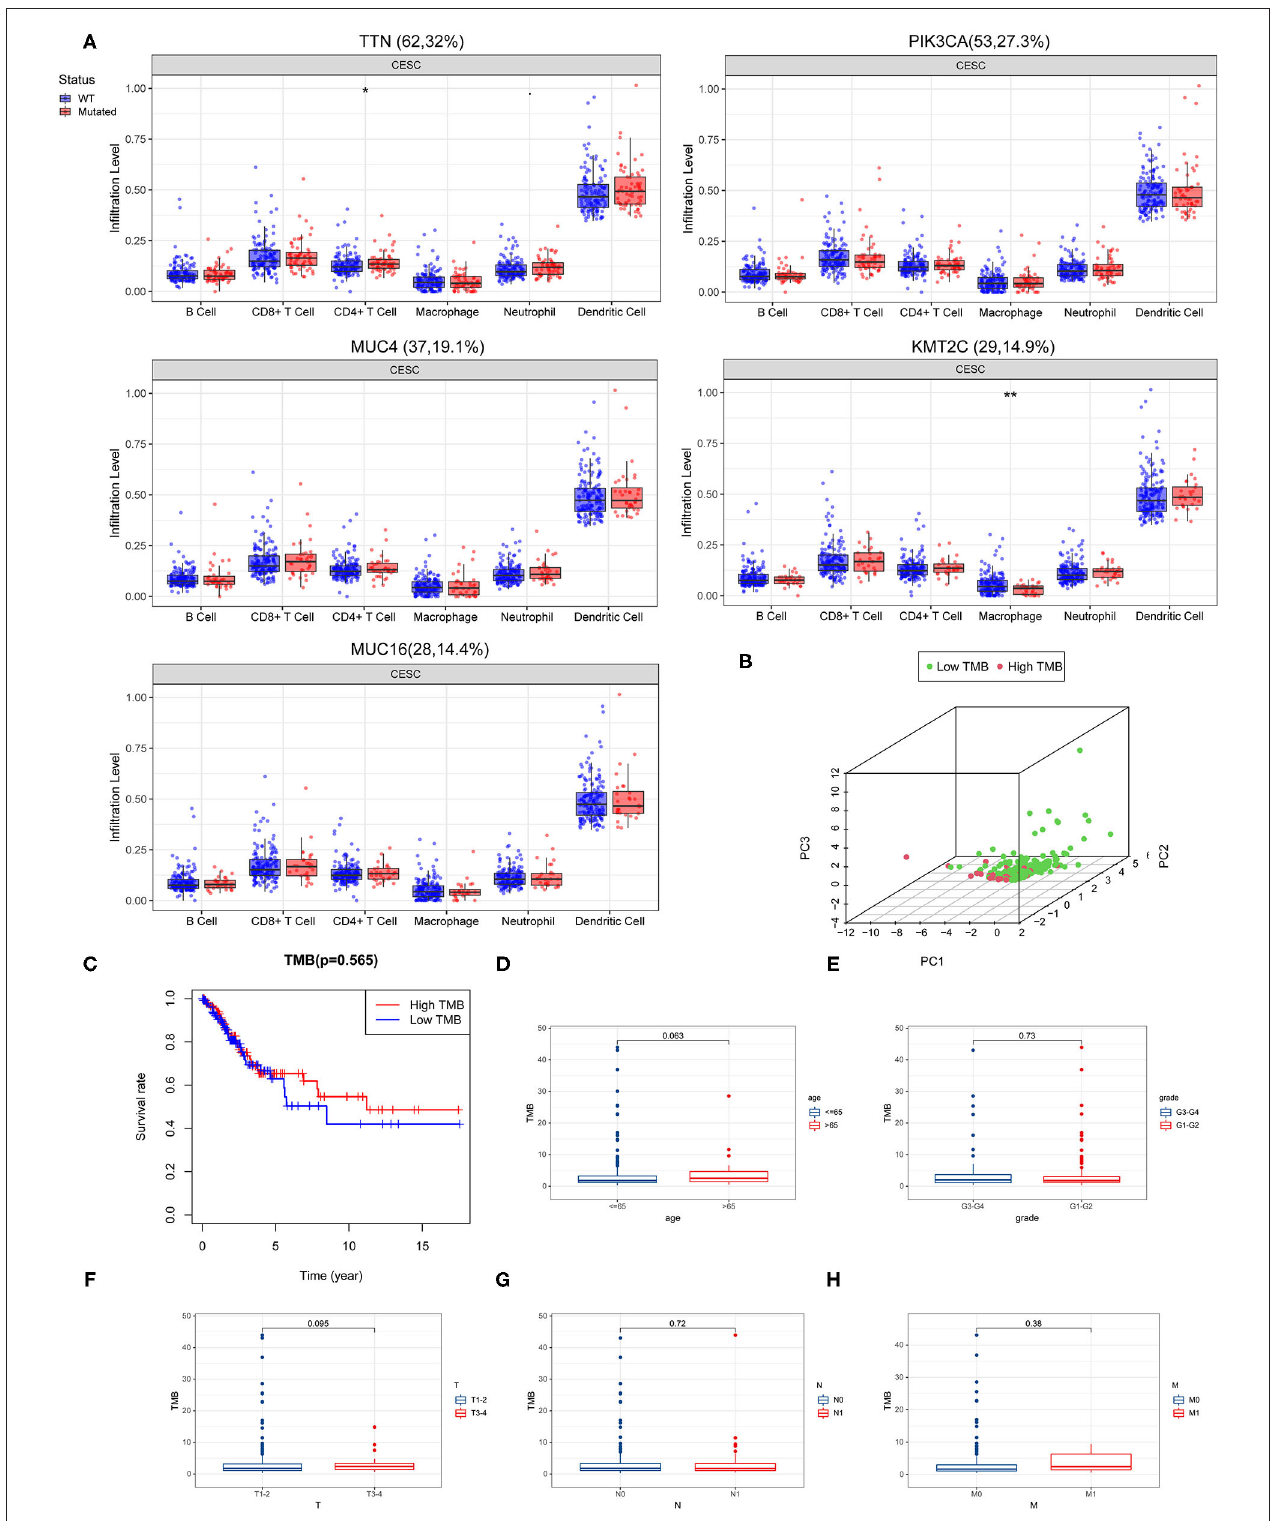
FIGURE 2 | Correlation of tumor mutation burden (TMB) with survival outcomes and clinical parameters. (A) Association of the top five mutant genes with immune cell infiltration in the CESC microenvironment. (B) Principal component analysis (PCA) plot representing the distinction between the high and low TMB groups. (C) High TMB group was associated with higher overall survival. (D–H) TMB correlated with clinical parameters.